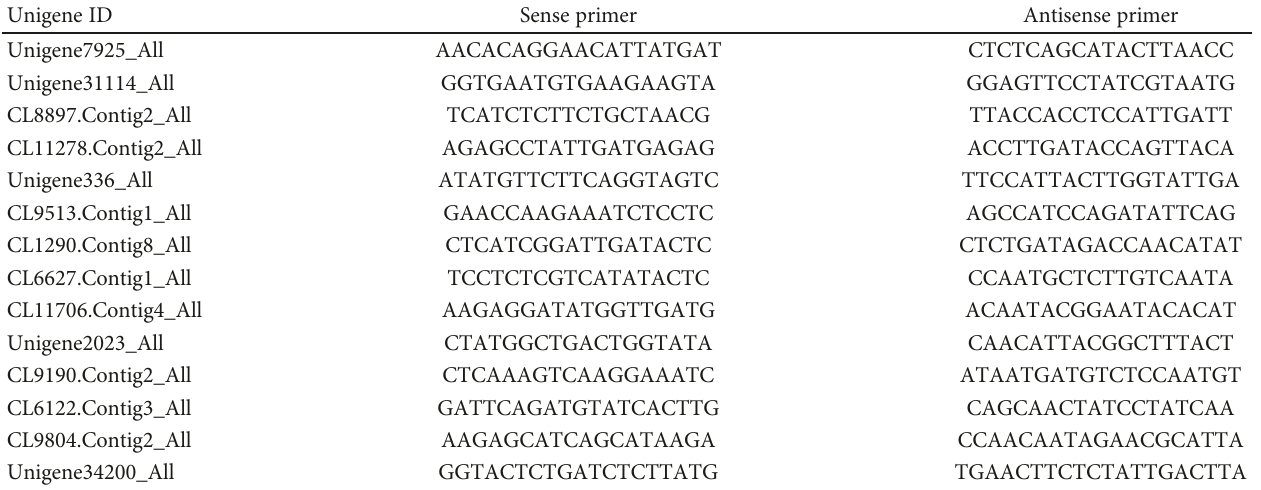
Table 1: Primers of 14 genes used for qRT-PCR